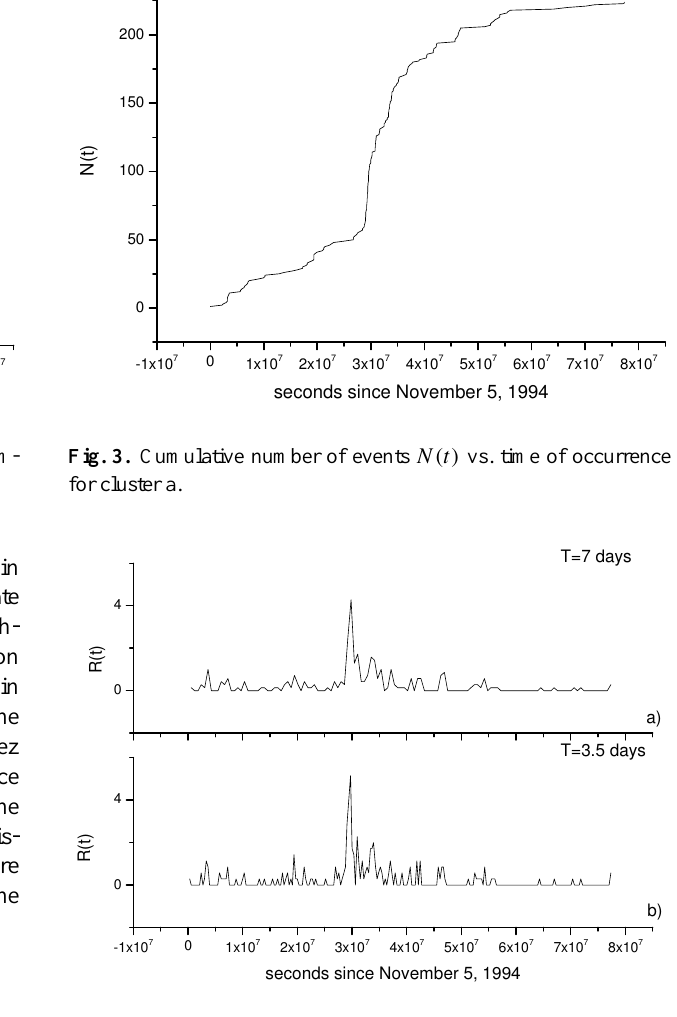
Fig. 4. Local rates for cluster a with time window of 7 days (a) and 3.5 days (b)